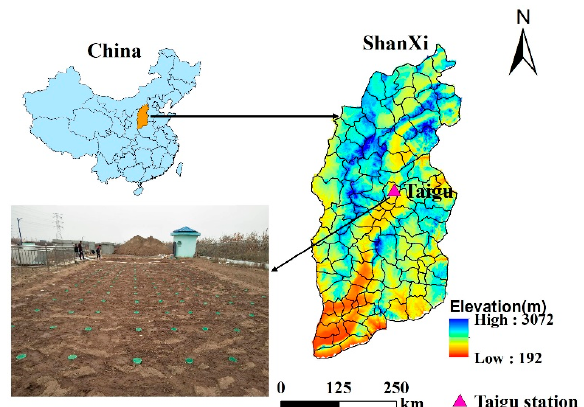
Figure 1. Location of the experimental site in Shanxi Province, China.